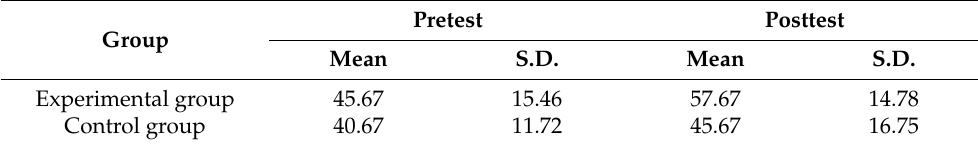
Table 2. Results of descriptive statistics on pretest and posttest